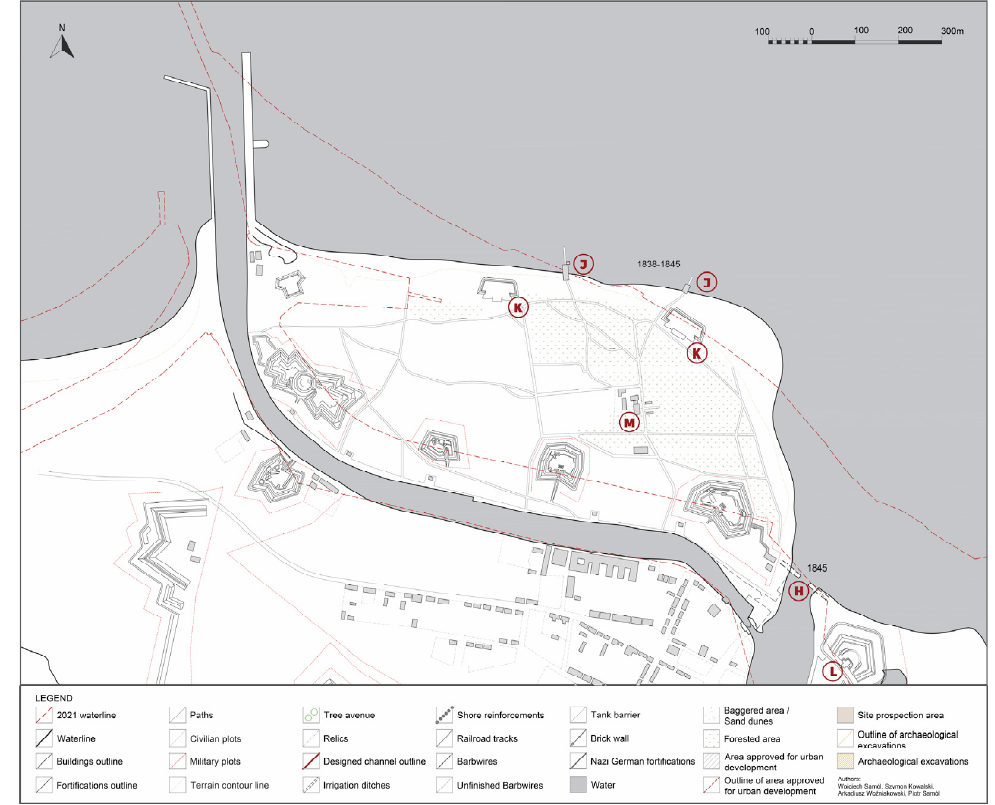
Figure 7. Westerplatte strengthened with the coastal batteries along with the beginnings of the resort facilities (in 1846).